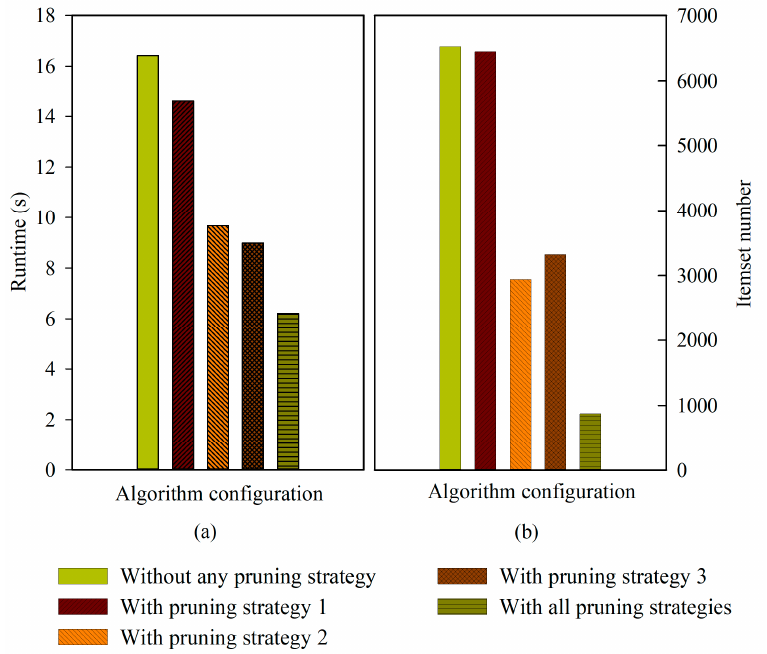
Figure 10. Pruning strategy comparison of different algorithm configurations. ( a ) Runtime comparison. ( b ) Itemset number comparison.